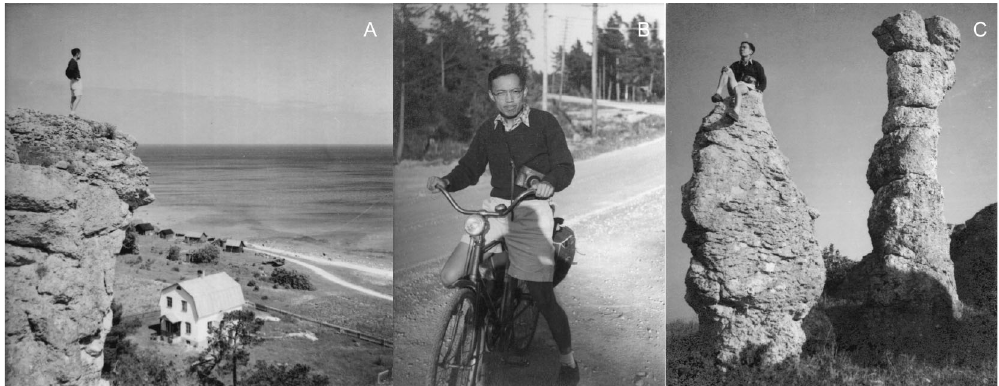
Figure 1. In Sweden in early 1950s (Photographs courtesy of Ms. Hua